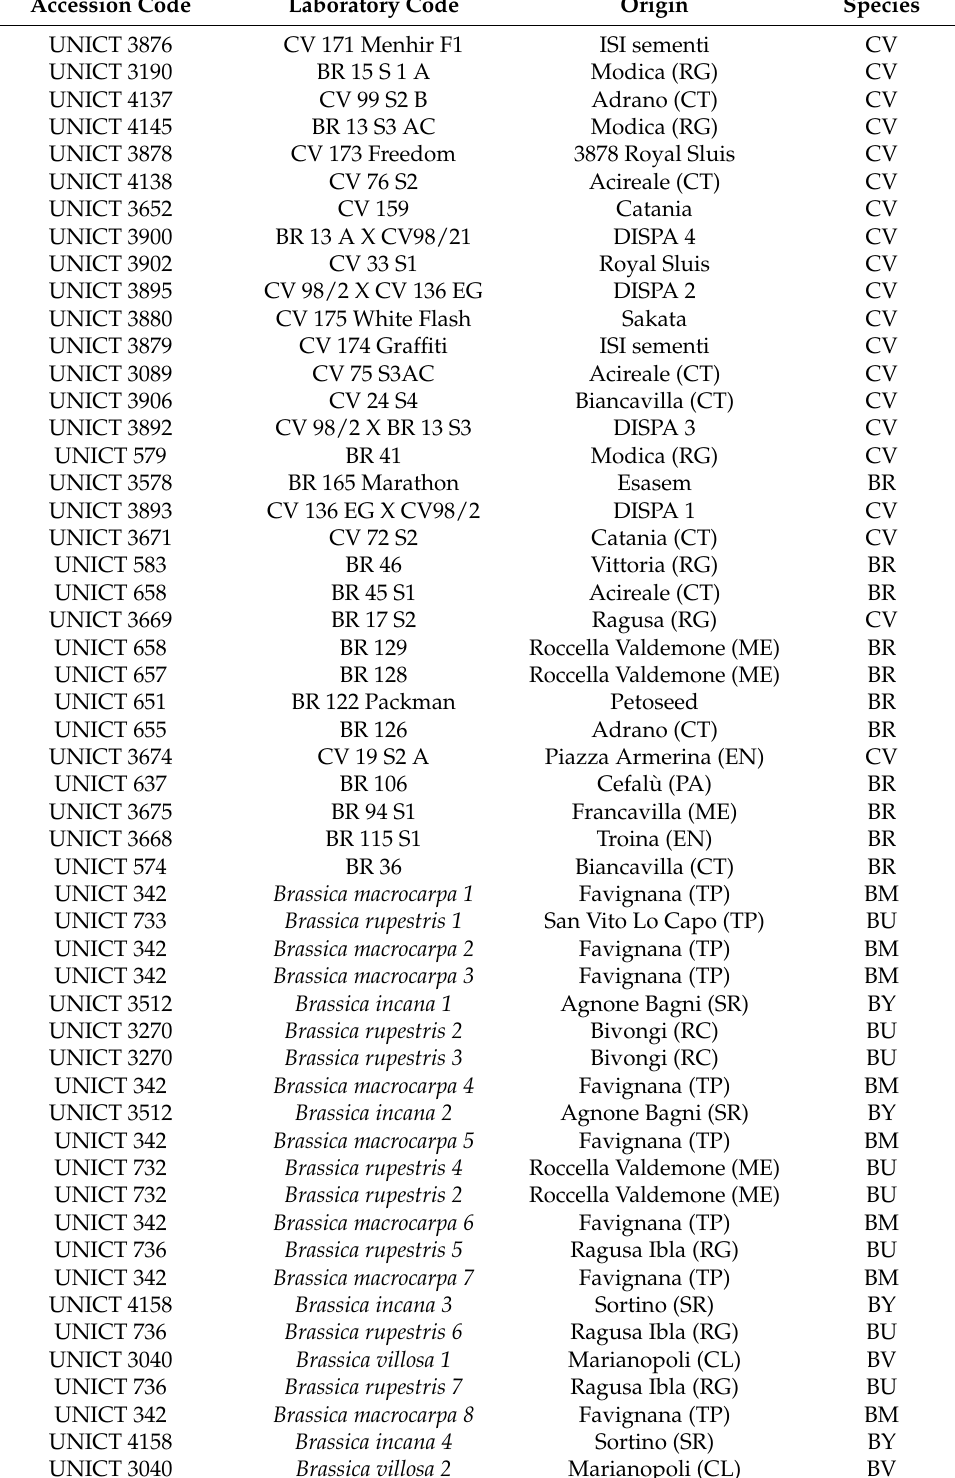
Table 1. List of B. oleracea complex species ( n = 9) accessions